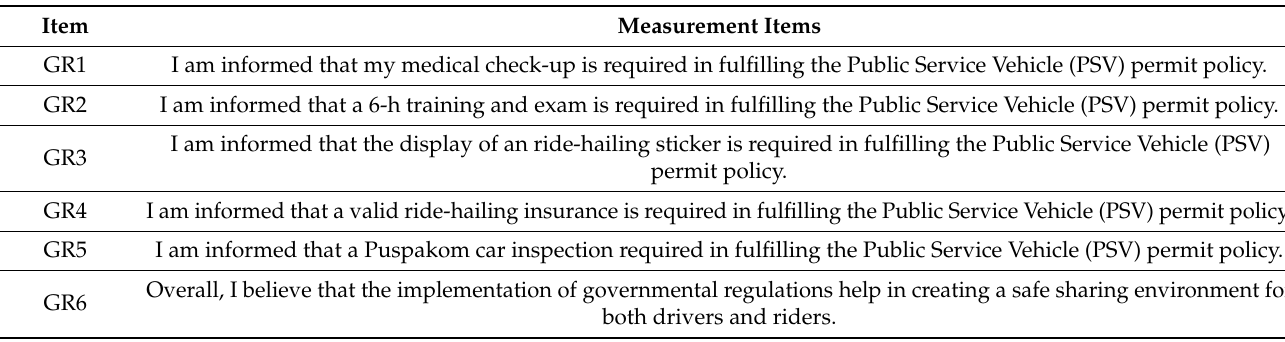
Table A2. Governmental Regulations Measurement